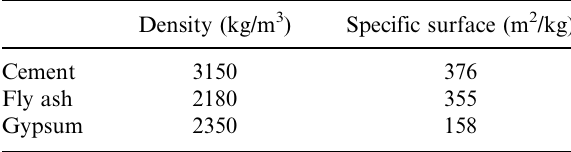
Table 1. Density and specific surface of materials